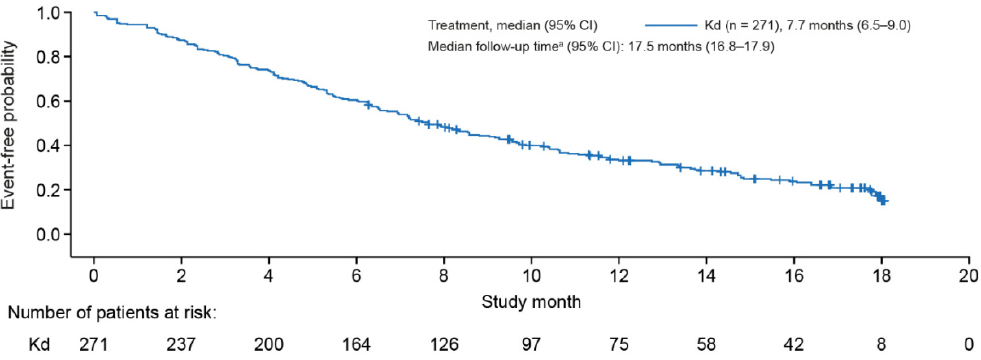
Figure 1. Kaplan–Meier estimates of overall time to discontinuation of carfilzomib for patients with MM receiving treatment with Kd . Time to discontinuation is defined as the time from carfilzomib initiation date to the date of treatment discontinuation. An event is defined as the discontinuation of carfilzomib. Patients who have not discontinued carfilzomib are censored on their last recorded non-zero dose date. a Estimated using reverse Kaplan–Meier method [16] . CI, confidence interval; Kd = carfilzomib combined with dexamethasone; MM = multiple myeloma.